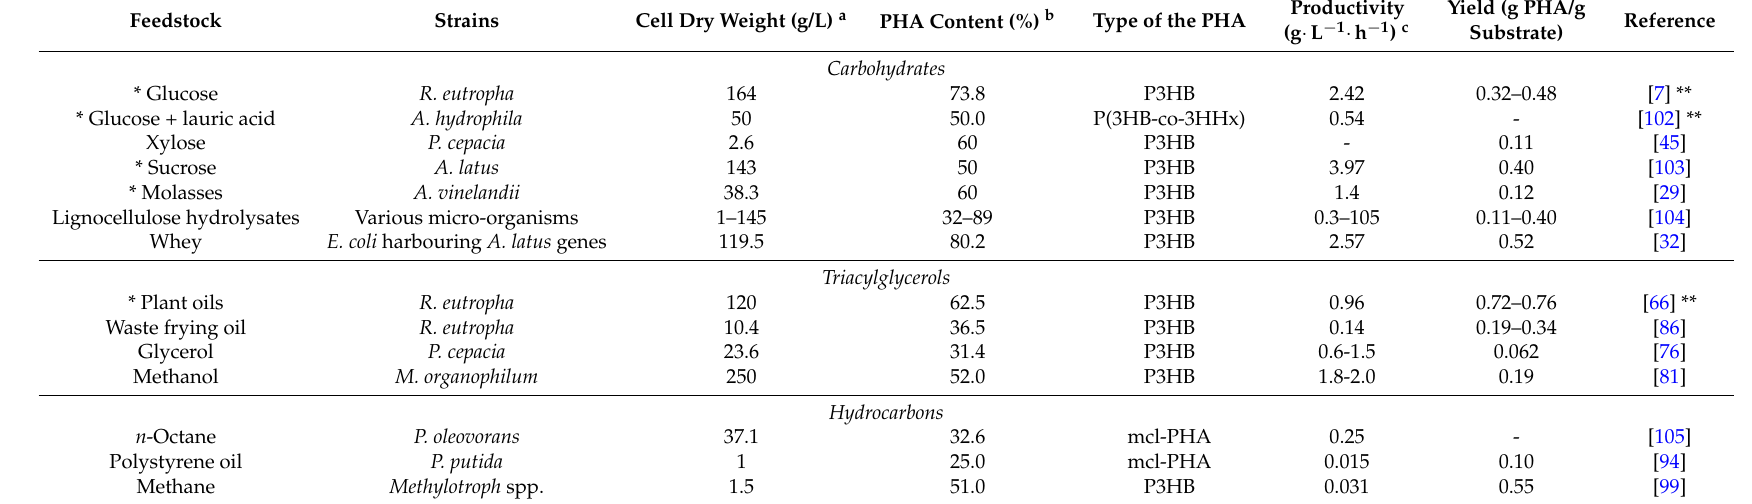
* Commercially-used carbon source; ** large-scale data; a cell dry weight (CDW) is the mass of dry cells in a bioreactor; b PHA content is the percentage of mass of PHA in dry mass of cells; c productivity is calculated by the following formula: productivity = PHA content/time of fermentationan important parameter for measuring the efficiency of a fermentation process. Hyphen indicated no data